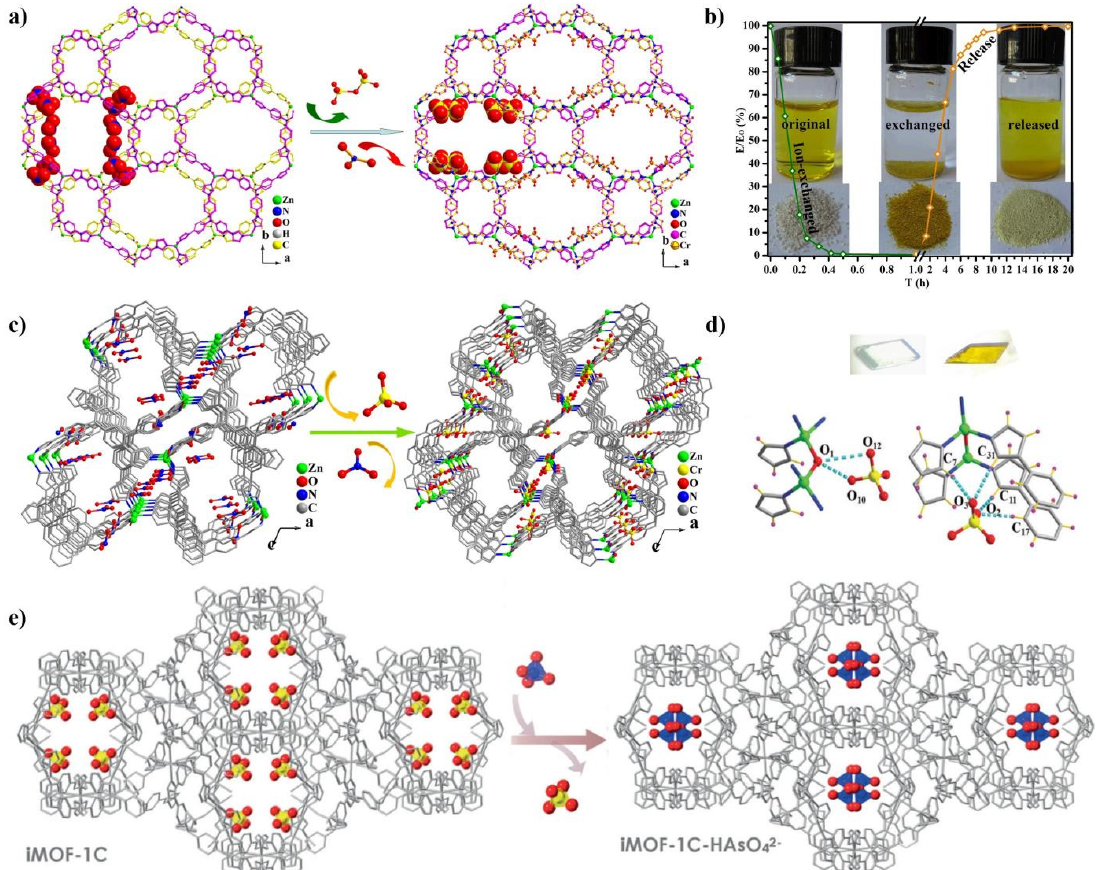
Figure 4. ( a ) Structures of FIR ‐ 53 before and after ion exchange: 3D structure of FIR ‐ 53 containing NO 3 − along the c axis, 3D structure of FIR ‐ 53 containing Cr 2 O 72 − along the c axis. ( b ) Photographs show the color of crystals before and after trapping − releasing process. Reproduced with permission [58]. Copyright 2015, the American Chemical Society. ( c ) A 3D structure of compound [Zn 2 (TIPA) 2 (OH) (NO 3 ) 3 ] ∙ 5H 2 O along the b ‐ axis: NO 3 − ions as guests in the channels, CrO 42 − ions instead of NO 3 − located in the channels. ( d ) H bonds between the framework and CrO 42 − , color change of FIR ‐ 53 crystals before and after ion exchange. Reproduced with permission [62]. Copyright 2018, Royal Society of Chemistry. ( e ) Packing diagram representing Single ‐ Crystal ‐ to ‐ Single ‐ Crystal transformation of parent cationic MOF, iMOF ‐ 1C, to HAsO 42 − encapsulated phase. Reproduced with permission [67]. Copyright 2020. John Wiley & Sons, Ltd.